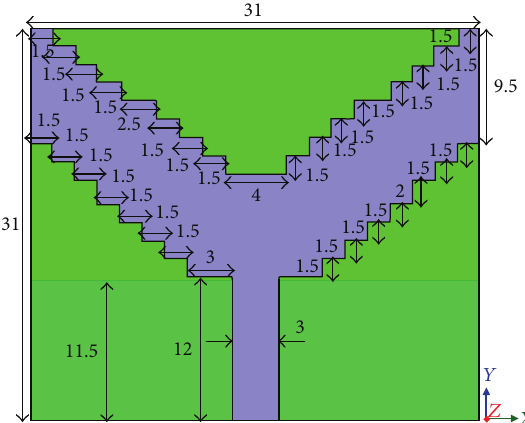
Figure 1: Geometry of the proposed UWB antenna without band rejected